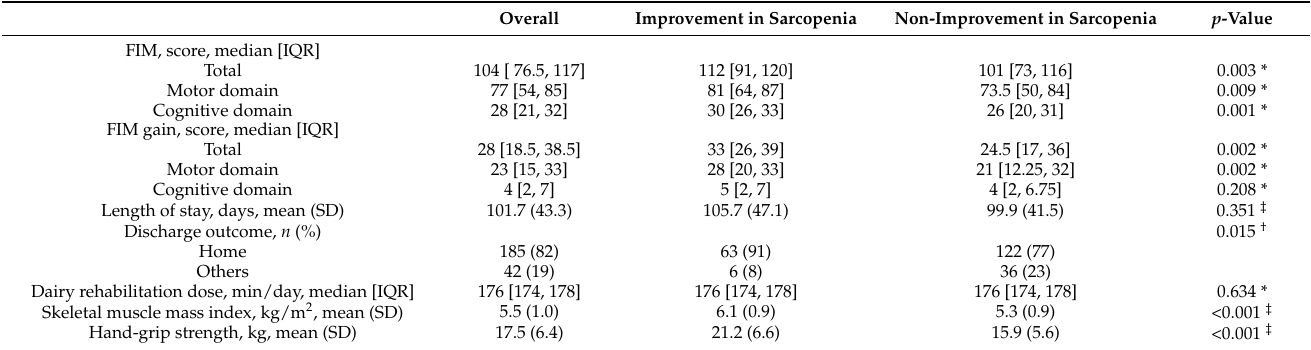
Table 2. Outcome measures at discharge from the convalescent rehabilitation ward in 227 post-stroke older patients with sarcopenia.